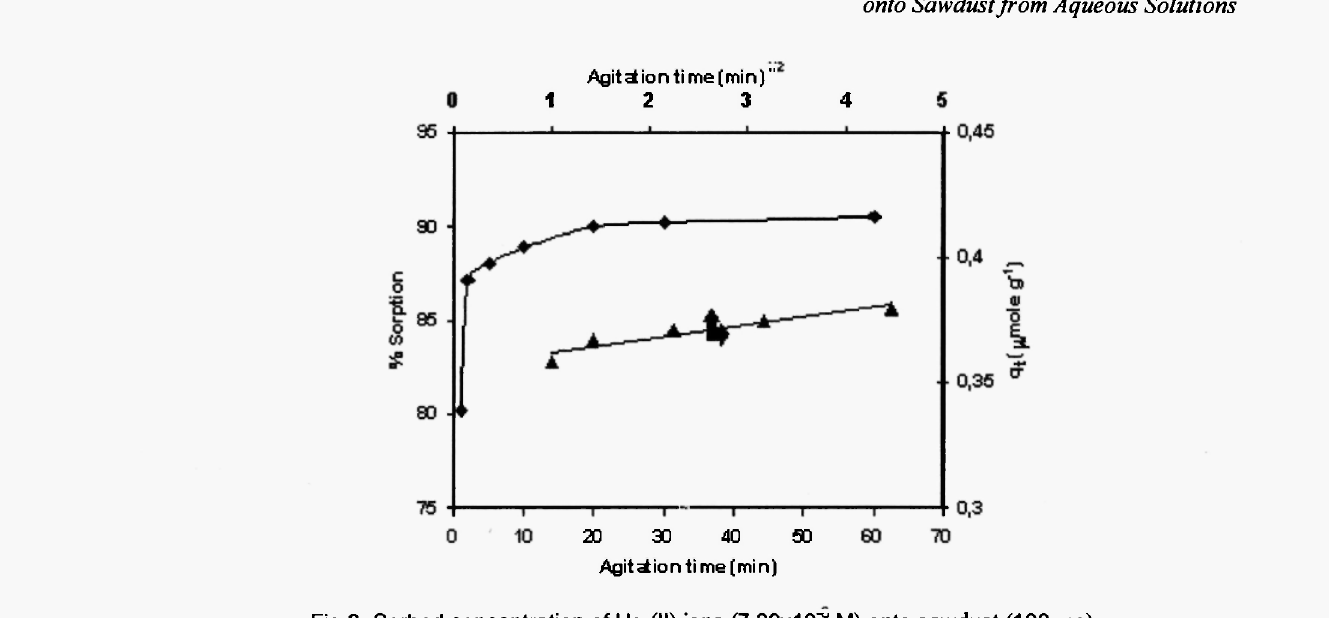
Fig 3. Sorbed concentration of Hg (II) ions (7.39x10 M) onto sawdust (100 mg) as a function of agitation time (t) • and t 1/2